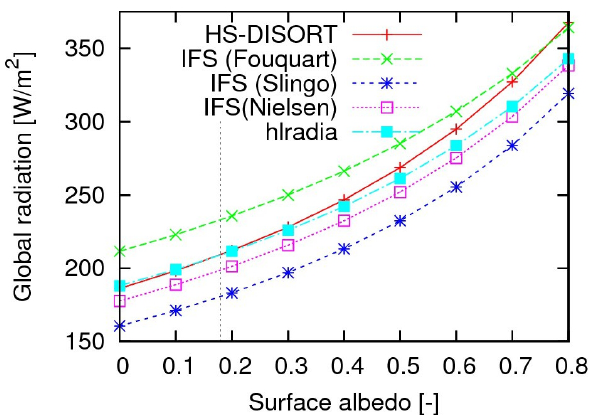
Figure 22. As for Fig. 1 but for varying cloud ice load and fixed surface albedo=0.18 (experiment 8). The vertical dashed line at 0.1kgm − 2 marks the cloud ice load used in experiments 10 and 11.